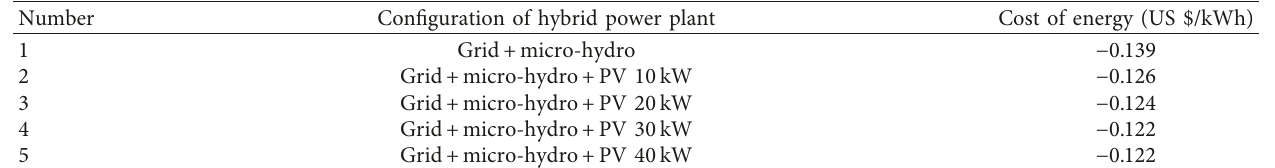
Figure 20: Grid sales for various configurations of the hybrid power plant systems. Table 5: COE for various configurations of the hybrid power plant systems.